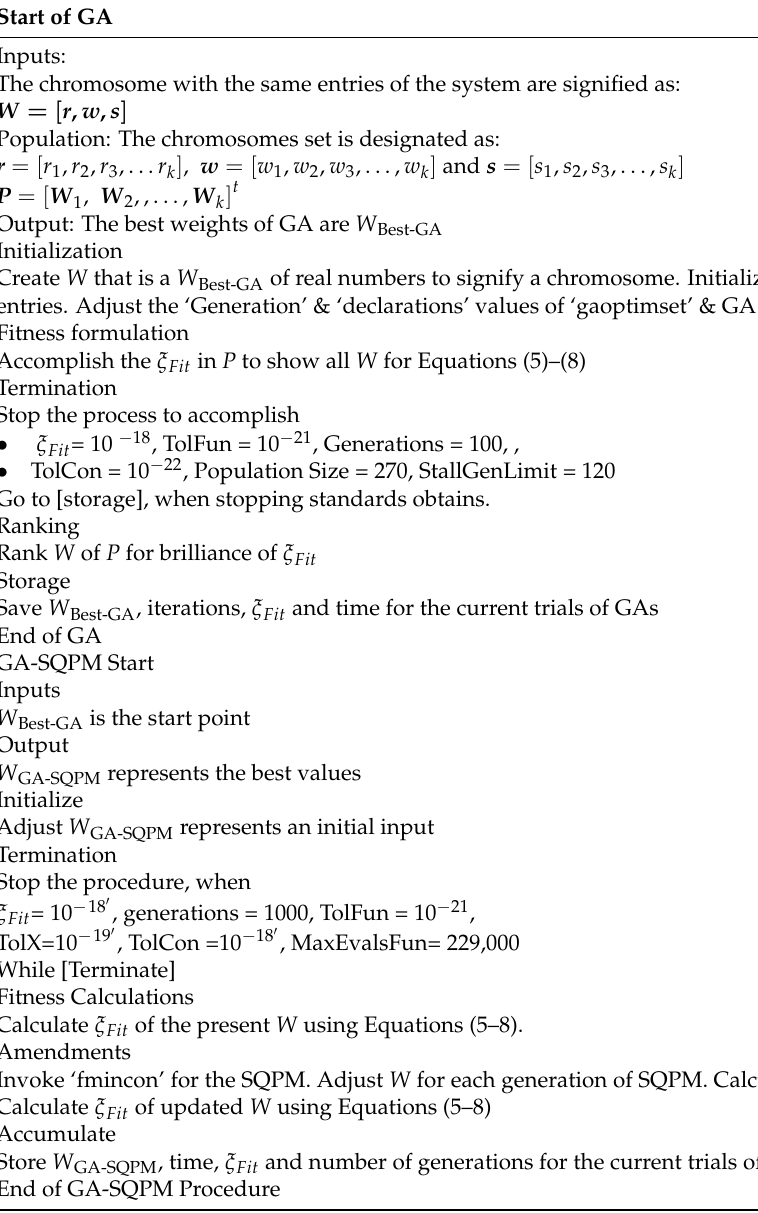
Table 1. Pseudocode of the process of optimization using the